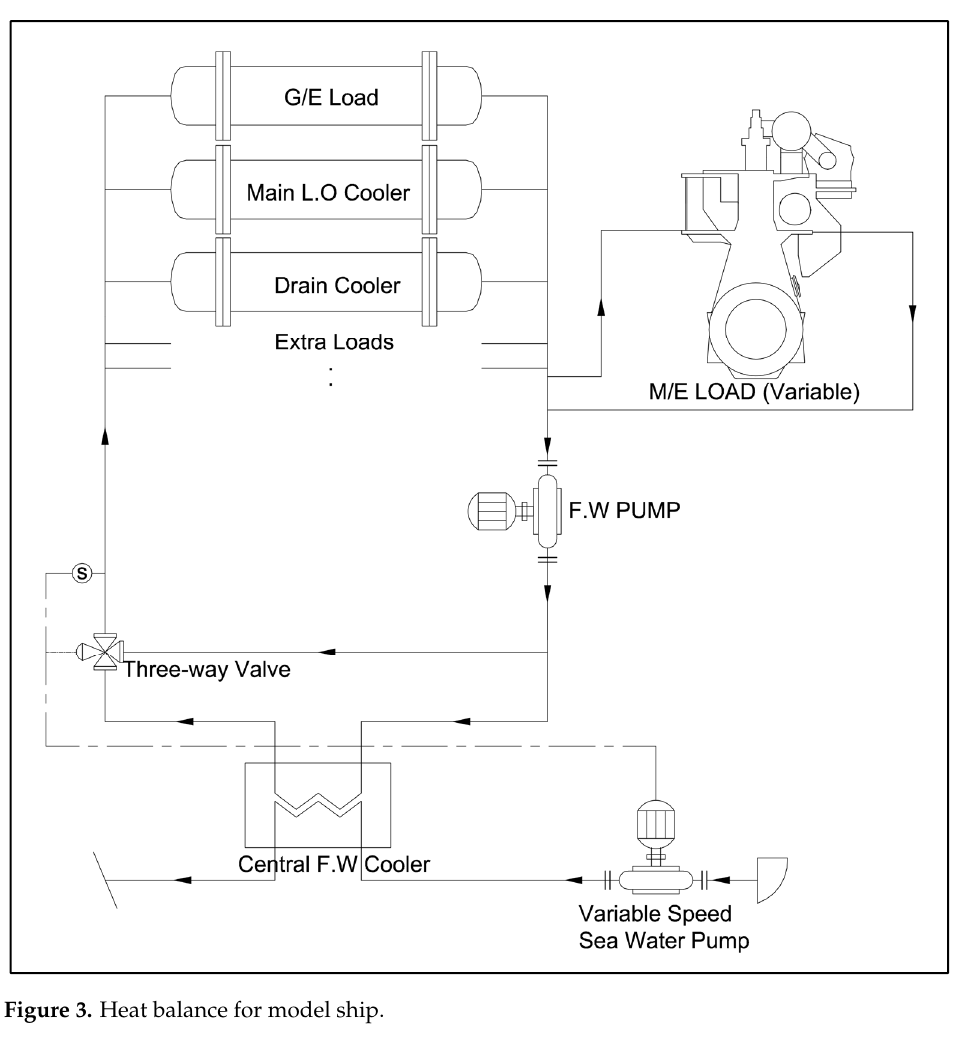
Figure 3. Heat balance for model ship.